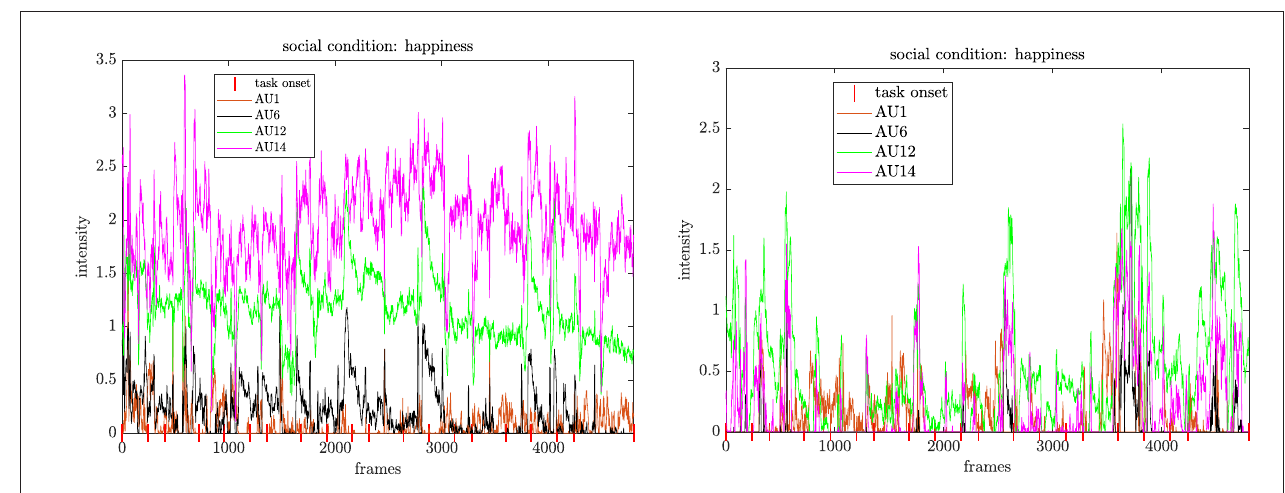
FIGURE 11 | Concurrent activation of action units representing the “happiness” class. While most of the co-activation appears at task onset, the activation decays slowly in between two tasks. This pattern might display a positive relation between the human and the socially-behaving robot.